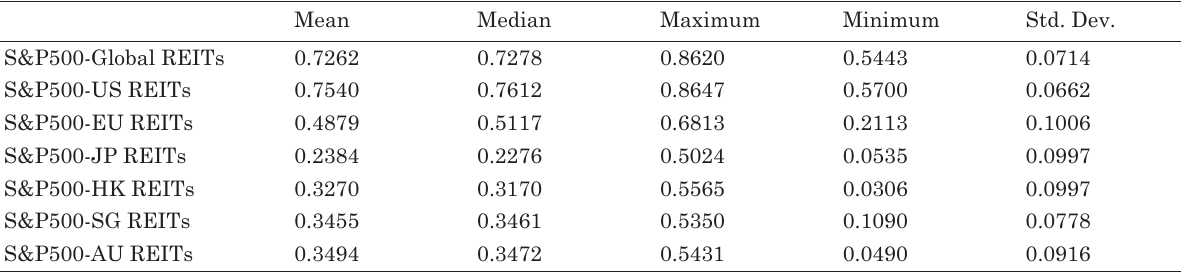
Table 4. Dynamic conditional correlation (sample period: